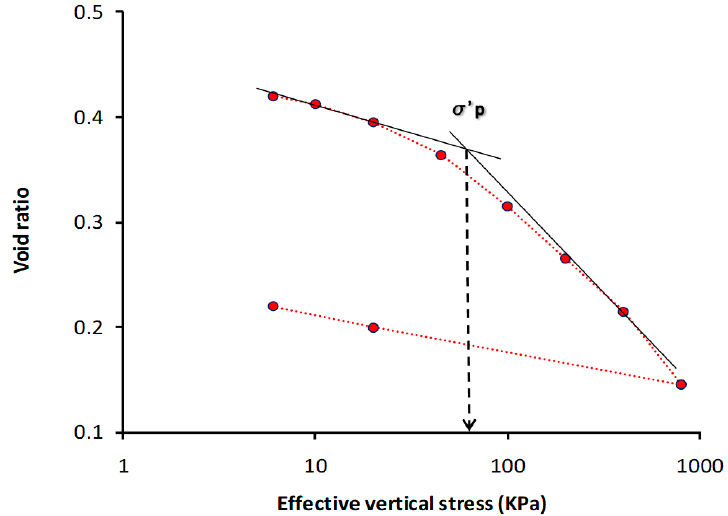
Figure 4. Compressibility curve of compacted CMWR material.